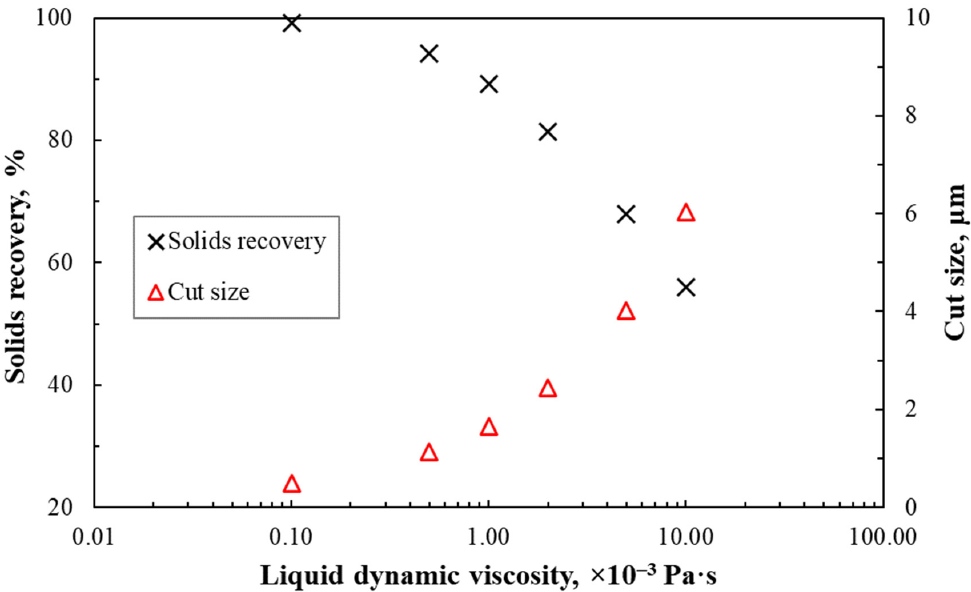
Figure 14. Effect of the liquid dynamic viscosity on the solids recovery and cut size.